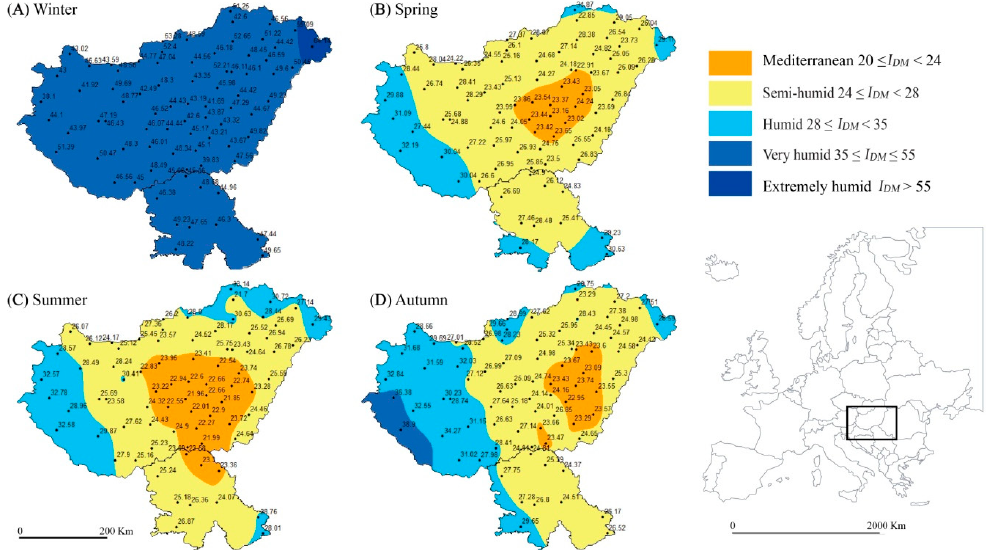
Figure 4. The spatial distribution of the seasonal De Martonne Aridity Index for Hungary and Vojvodina jointly during the period 1949–2017; ( A ) winter, ( B ) spring ( C ) summer, and ( D ) autumn.